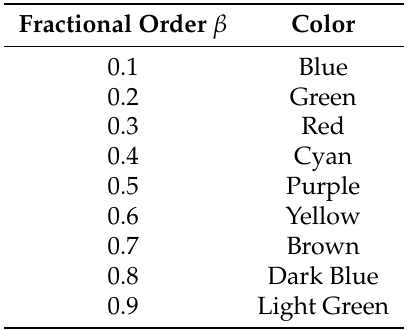
Figure 2. 3d Plot of the position of the trajectory being tracked. Table 3. Distinct fractional orders β .